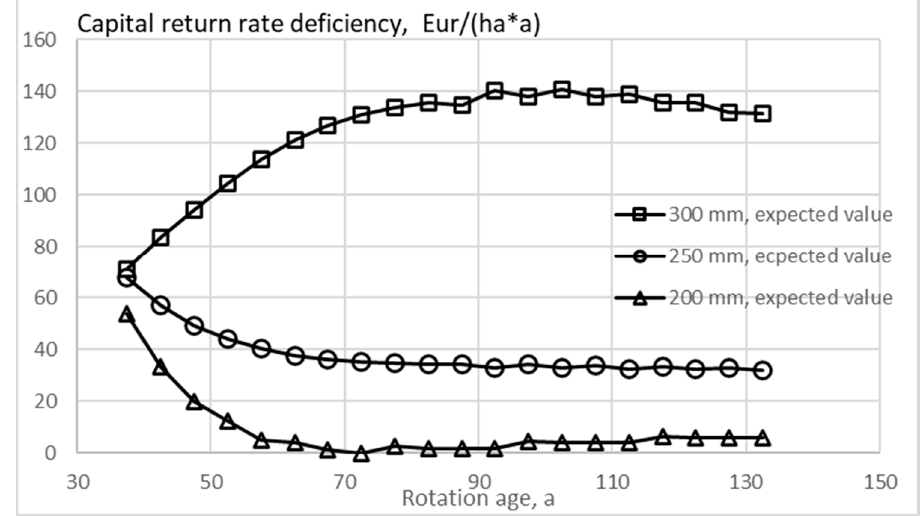
Figure 6. Capital return rate deficiency in Euros per hectare and year, for different rotation ages and three different cutting diameter limits (200 mm, 250 mm, and 300 mm).